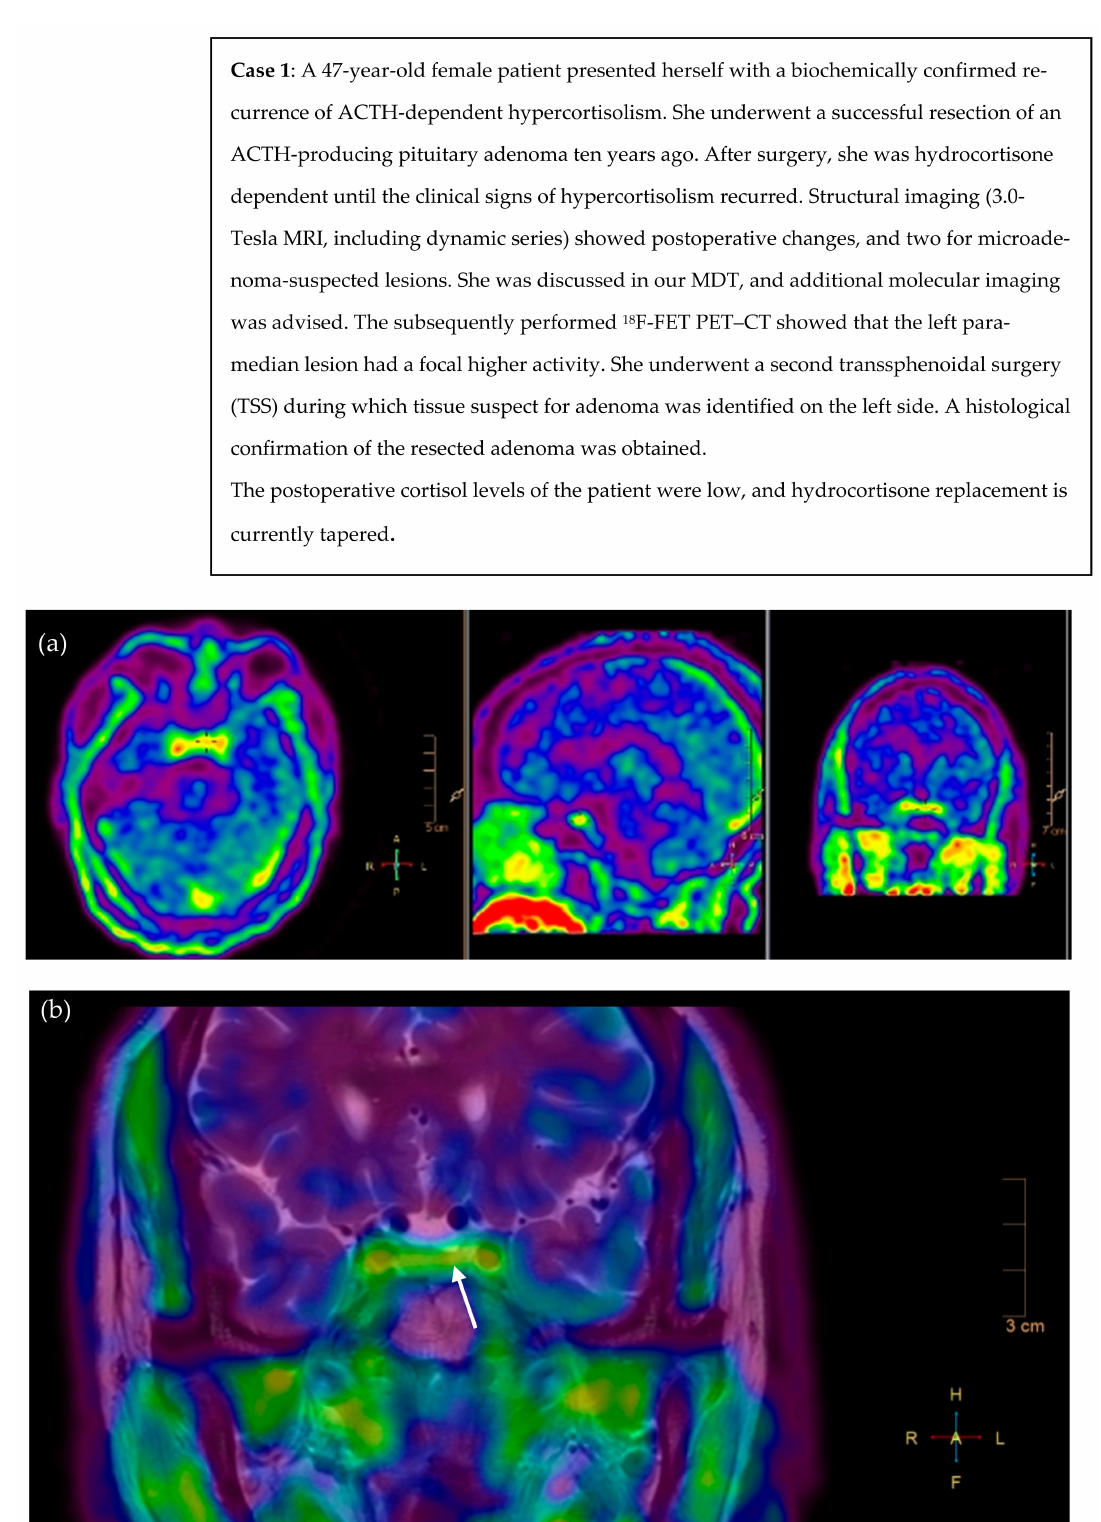
Figure 1. 18 F-FET PET scan and fusion of PET with T2 MR images reveal asymmetrical focal high uptake (in orange) in a pituitary adenoma left paramedian, as shown with the crosshair ( a ) and white arrow ( b ). ( a ) axial, sagittal, and coronal view of PET scan after infusion of 219 MBq 18 F-FET, ( b ) fusion of PET/MRI (T2-weighted coronal view, pre-gadolinium). L = left, R = right, H = head, F =